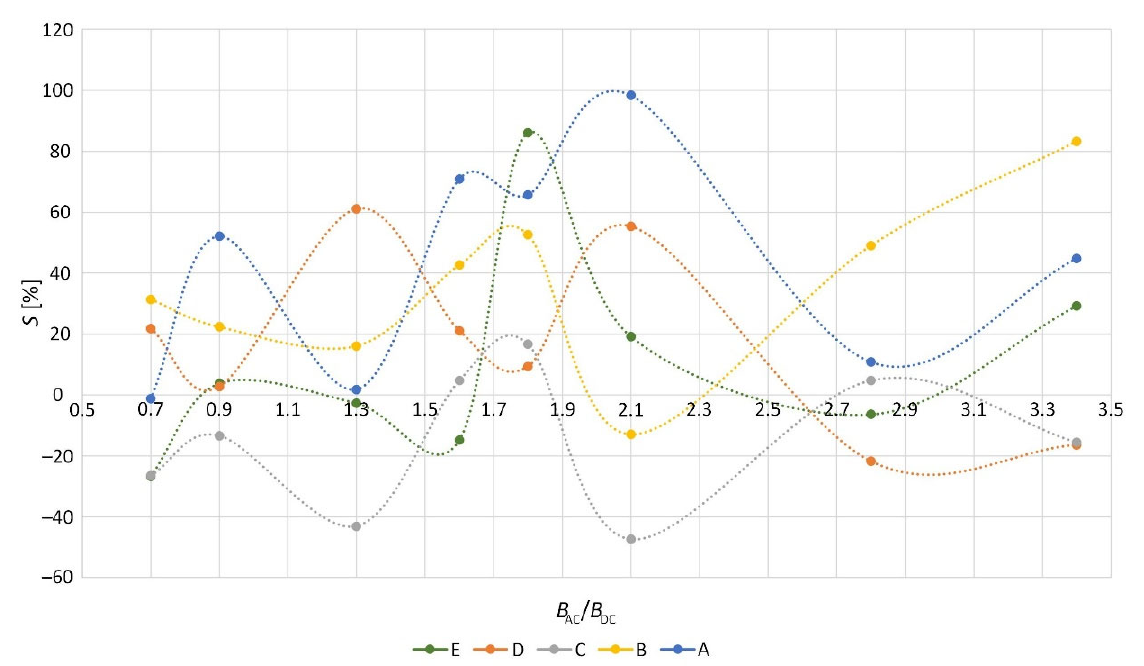
Figure 5. Dependence of the response rate parameter S of a biological system on the change in magnetic flux density ratio.